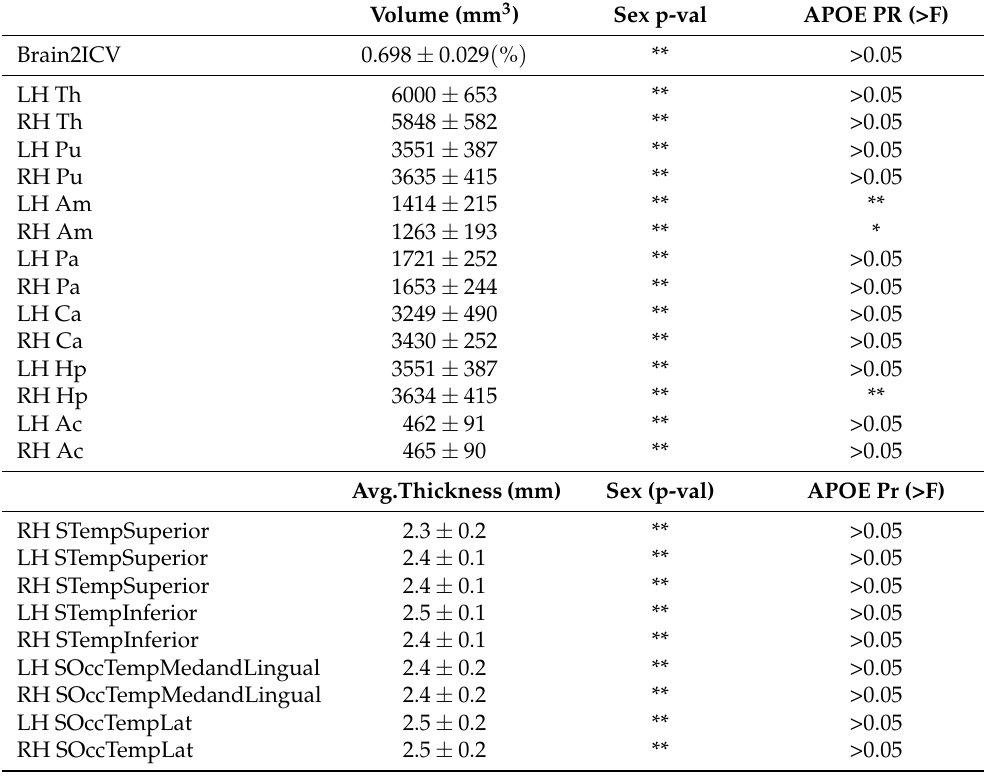
Table 2. The table columns from left to right include the name of the subccortical or cortical area, the gray matter volume (mm 3 ) for subcortical structures, the cortical thickness (mm) defined for areas in the surface cortical atlas used, and the p -values of the T -test and the ANOVA test for Sex and APOE4 variables, respectively. The first row of data shows the brain-to-intracranial-volume (Brain2ICV) ratio, followed by the subcortical structures: thalamus, putamen, amygdala, pallidum, caudate, hippocampus, and accumbens. Next, the parcellation defined in [27], in which, the cortex is divided into gyral and sulcal regions. The brain areas names on the left column are self-descriptive, with LH and RH referring to each hemisphere: the first letter S, G refers to gyral or sulcal thickness. (<0.05 (*) <0.01